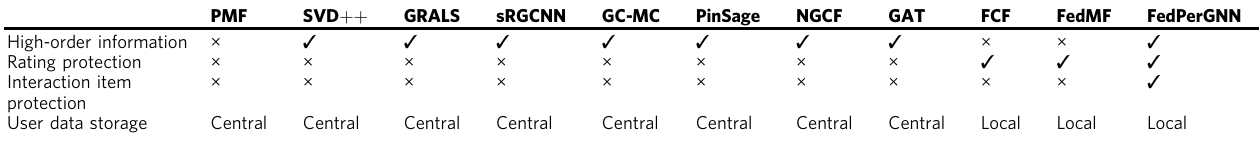
Table 2 Comparison of different methods in high-order user-item interaction modeling and privacy protection. PMF SVD ++